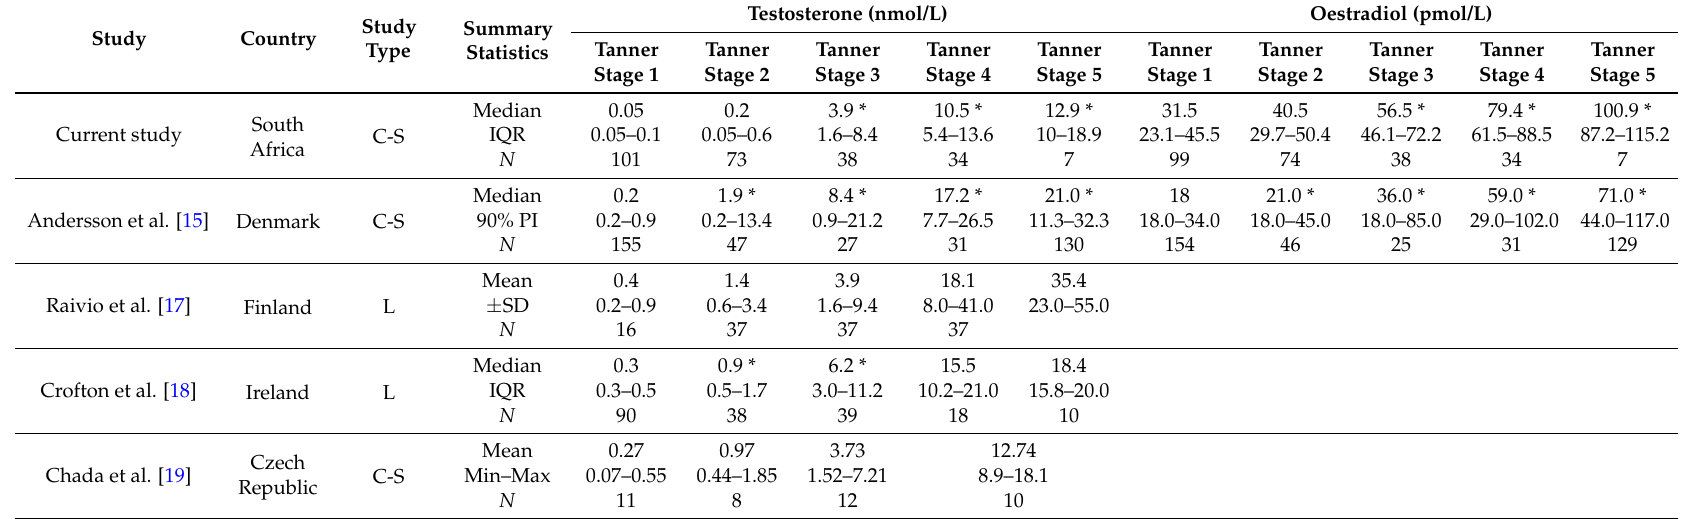
Table 7. Levels of sex steroids during sexual development in this study compared with other published